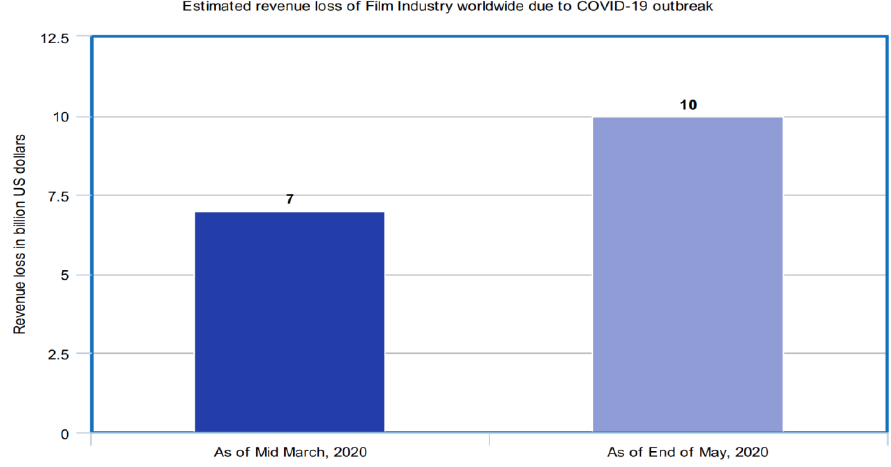
Figure 12. Estimated revenue loss of the film industry worldwide due to the COVID-19 outbreak